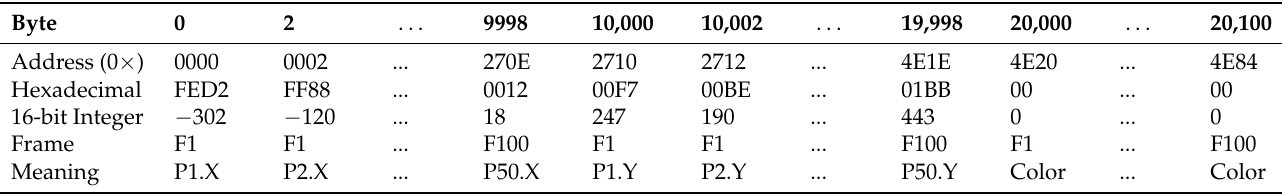
Table 3. Fragments of a stimulus file cl201.bin.